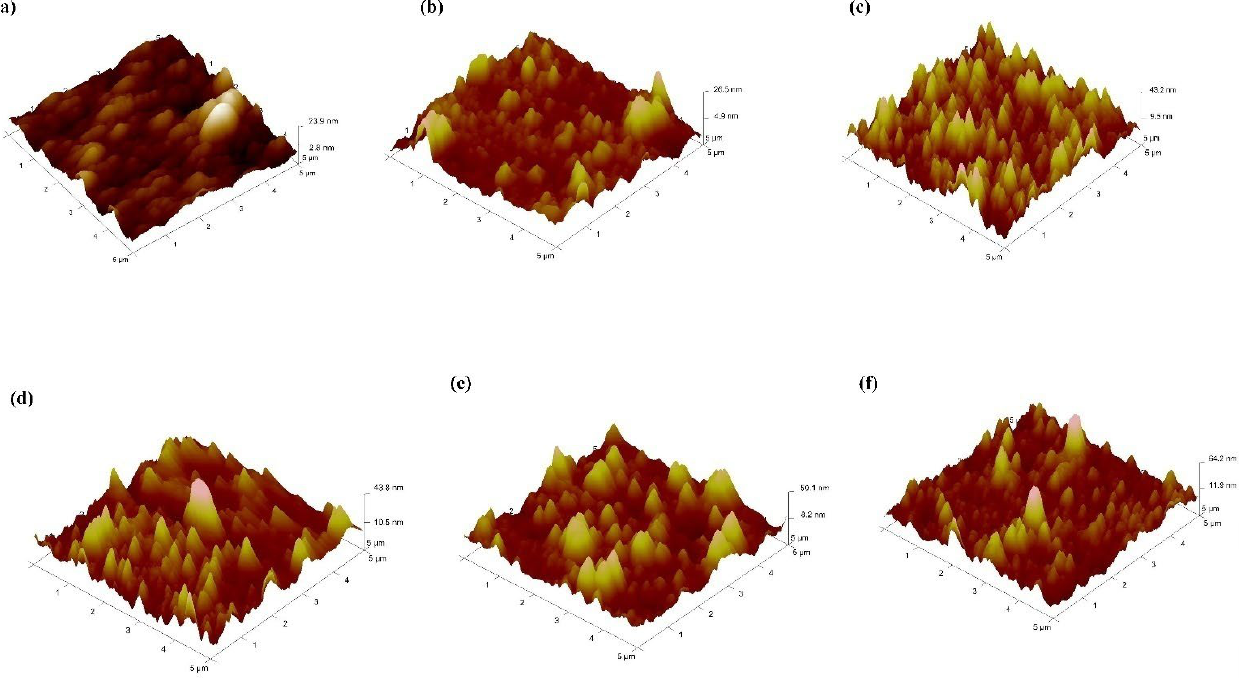
Figure 4. AFM images of the active layer ( a ) without NPs, ( b ) with Au@Ag NPs-2%, ( c ) with Au@Ag NPs-4%, ( d ) with Au@Ag NPs-6%, ( e ) with Au@Ag NPs-8%, and ( f ) with Au@Ag NPs- 10%.